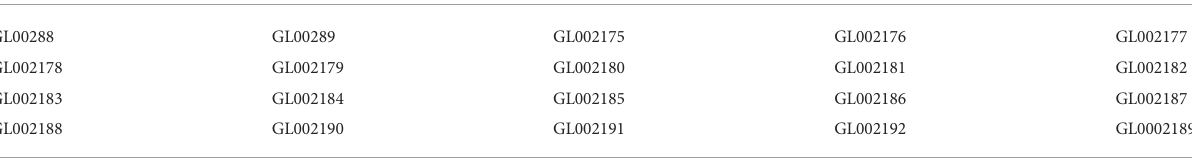
TABLE 3 Information of Brucella suis speci fi c